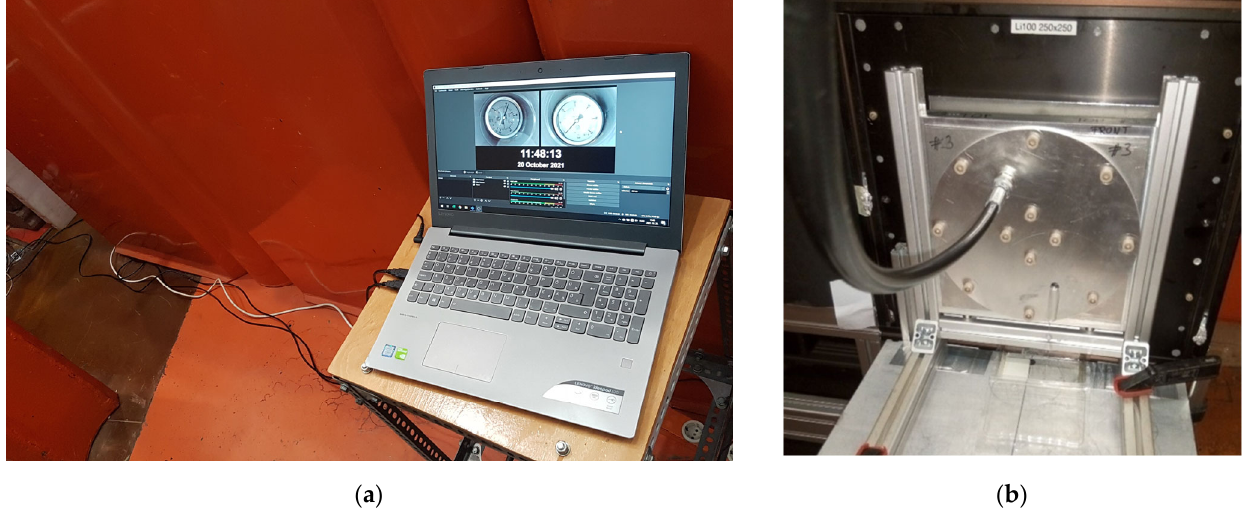
Figure 7. Details of the measurement setup. ( a ) View of the pressure gauges connected to a personal computer; ( b ) Test damper in a vertical measurement position, in front of the neutron imaging detector.